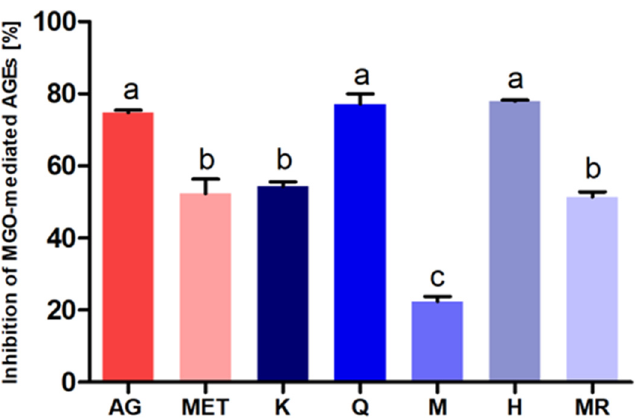
Figure 1. Antiglycation activity after seven days of incubation of BSA with MGO (0.5 mM) and the examined compound (1.5 mM) expressed as % inhibition of MGO-mediated AGE formation. The results are representative of three experiments performed in triplicate ± SD. Values not sharing a common letter are significantly different at p < 0.05 by Tukey’s multiple comparisons test. Abbreviations: AG, aminoguanidine; MET, metformin; K, kaempferol; Q, quercetin; M, myricetin; H, hyperoside; MR, myricitrin.